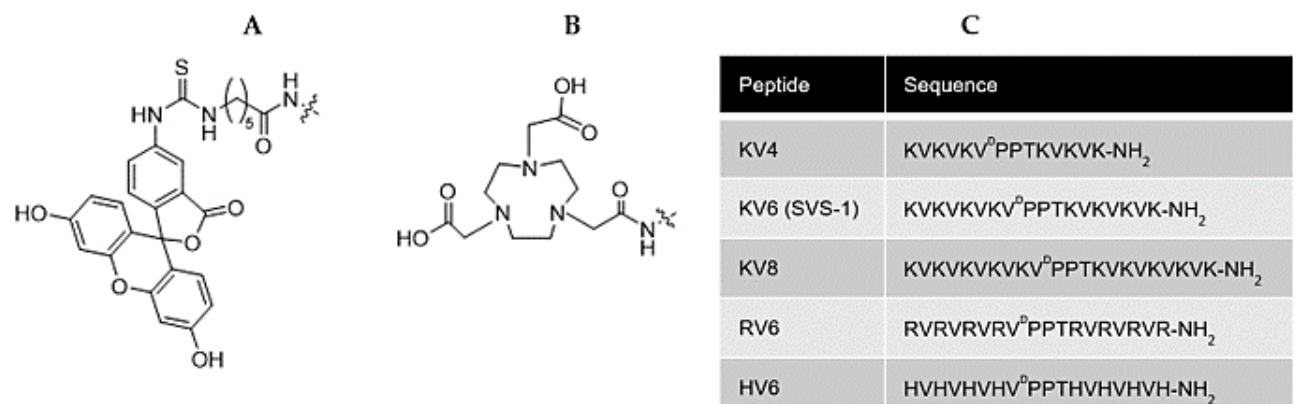
Figure 1. Design of fluorophore- and radiogallium chelator-conjugated cationic amphiphilic peptides (CAPs) as tumor imaging agents. Fluorescein- ( A ) and NOTA- ( B ) conjugated CAPs consisting of two segments of repeated cationic amino acid (lysine, arginine, or histidine) and valine residues joined by the β -turn tetrapeptide ( − V D PPT − , where D P is d-proline), which allows the peptides to form folded β -hairpin structures on interaction with cancer cell membranes. Five peptide sequences were used as CAPs in this study ( C ).